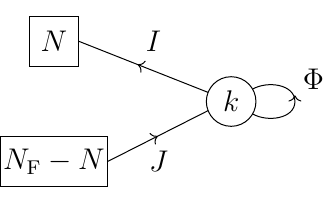
Figure 2 . = (2 ; 2) quiver gauge theory: it has 3 U( k ) vector multiplet, I , J and (cid:8) chiral N multiplets. It describes the moduli space of vortices of 4d, fundamental hypermultiplets; it becomes superconformal if N F = 2 N